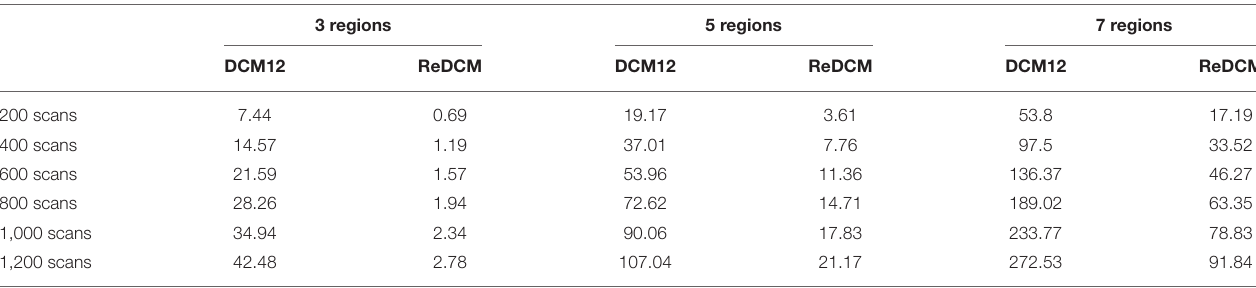
TABLE 2 | Summary of runtime comparison.